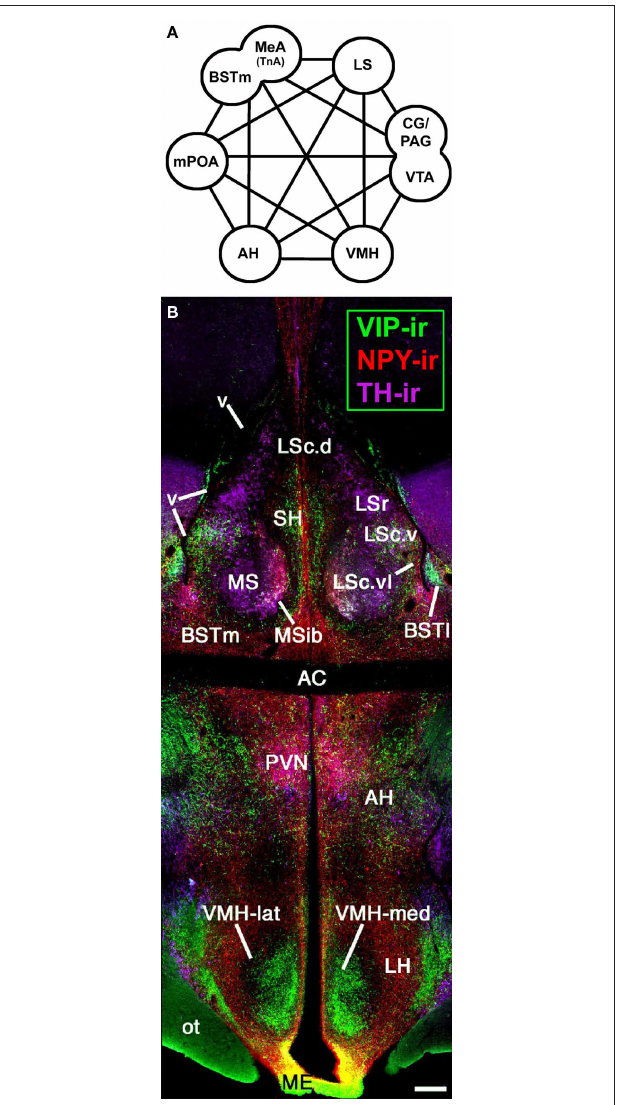
FiGure 1 | An evolutionarily conserved suite of brain regions that regulate vertebrate social behavior. (A) The core components of the social behavior network include numerous areas of the basal forebrain – the medial extended amygdala (medial amygdala, MeA, or taenial amygdala, TnA, plus the medial bed nucleus of the stria terminalis, BSTm), medial preoptic area (mPOA), anterior hypothalamus (AH), ventromedial hypothalamus (VMH), and lateral septum (LS), as well as areas of the midbrain, most notably the central gray (CG; or periaqueductal gray, PAG) and the ventral tegmental area (VTA). Modified from Newman (1999) and Maney et al. (2008). (B) A photomontage of a female zebra finch brain at the level of the anterior commissure (AC). Immunocytochemical triple-labeling for vasoactive intestinal polypeptide (VIP), neuropeptide Y (NPY), and tyrosine hydroxylase (TH) shows the location of the AH and multiple zones of the LS, BST, and VMH. The topography shown here is very similar across vertebrate groups, particularly among amniotes. Scale bar = 200 μm. Modified from Goodson, 2005. Other abbreviations: BSTl, lateral bed nucleus of the stria terminalis; Hp, hippocampus; LH, lateral hypothalamus; LSc, caudal division of the lateral septum (dorsal, ventrolateral, and ventral zones denoted as LSc.d, LSc. vl, and LSc.v, respectively); LSr, rostral division of the lateral septum; ME, median eminence; MS, medial septum; MSib, internal band of the medial septum; ot, optic tract; OM, occipitomesencephalic tract; PVN, paraventricular nucleus of